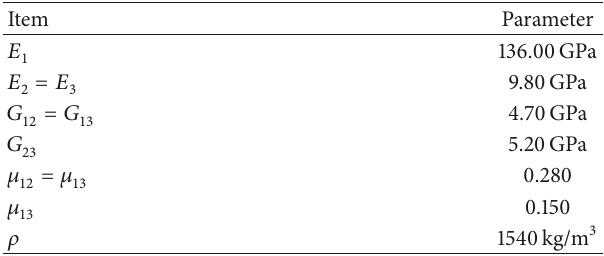
Table 2: Mechanical property